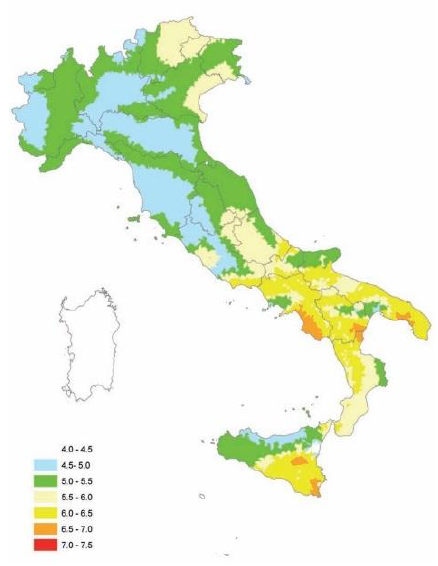
Figure 4. Average values of M W from disaggregation [52].